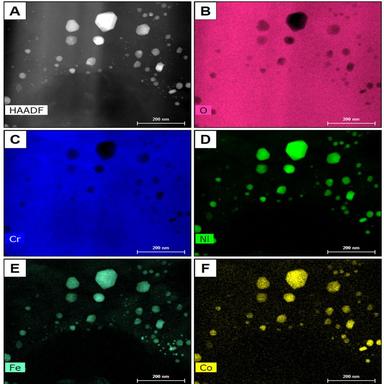
STEM-HAADF image of the area marked with a white rectangle in A (A) with corresponding STEM-EDXS distribution maps of selected elements (B–F).